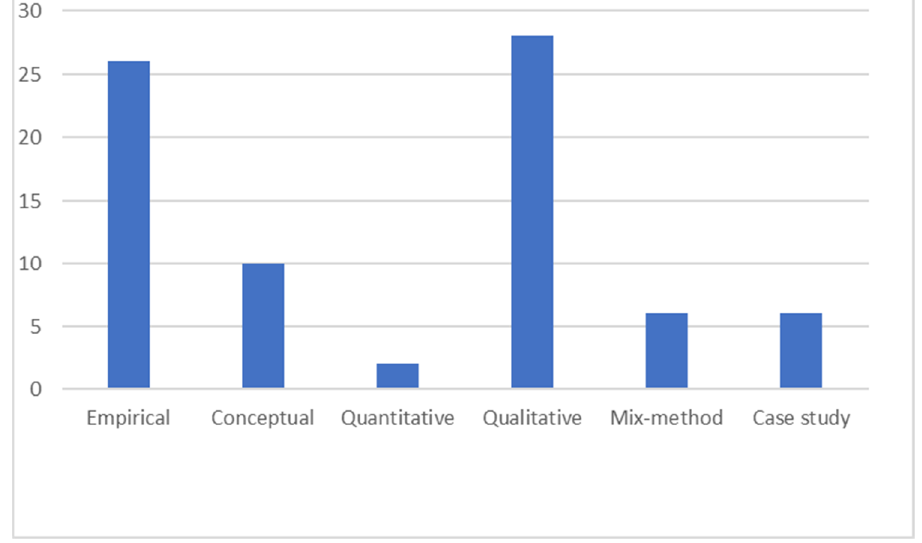
Figure 4. Research methods of